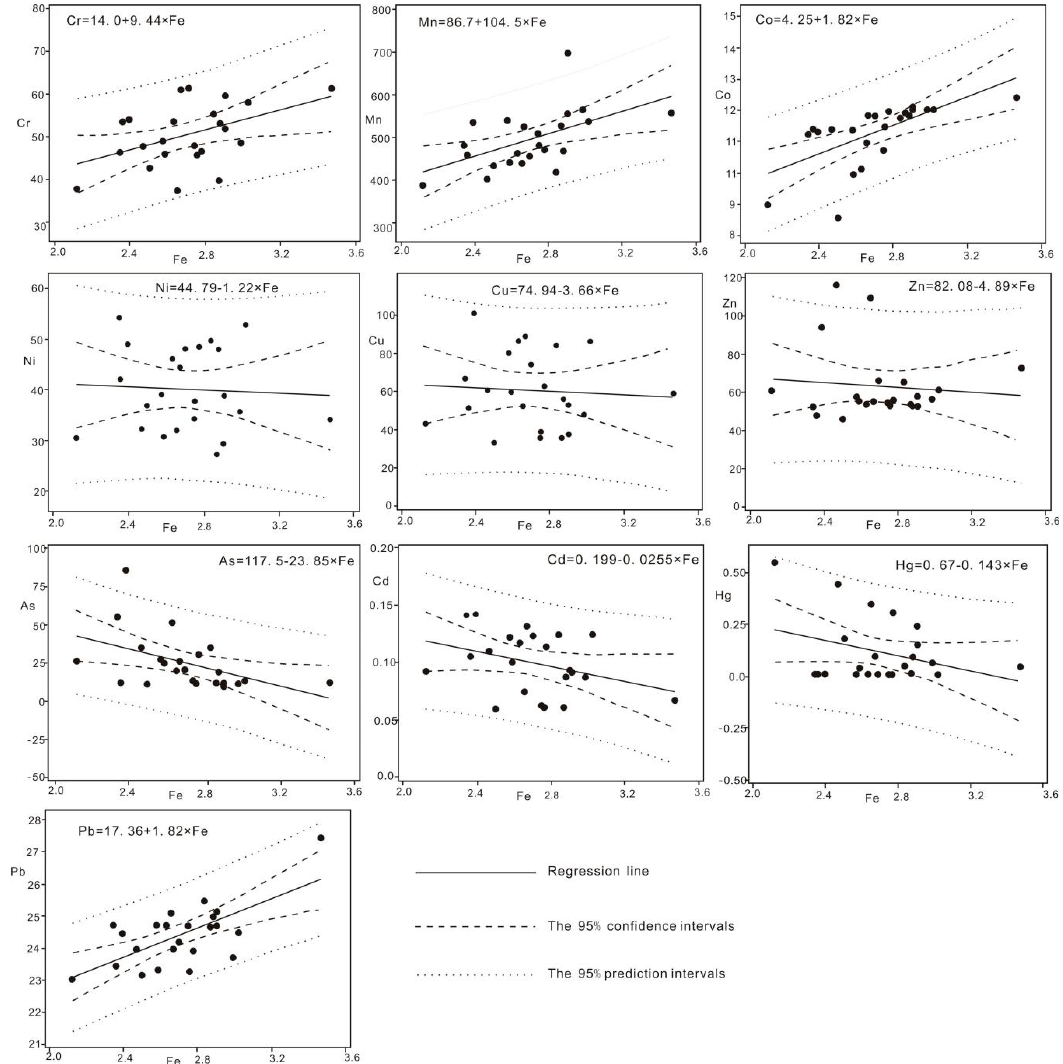
Figure 4. The linear regression models between the heavy metal elements and Fe of soils in the study area ( n =